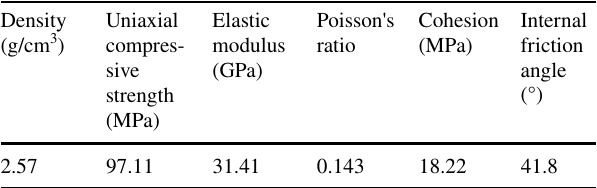
Table 1 Rock mechanical parameters of the Longmaxi shale Density (g/cm 3